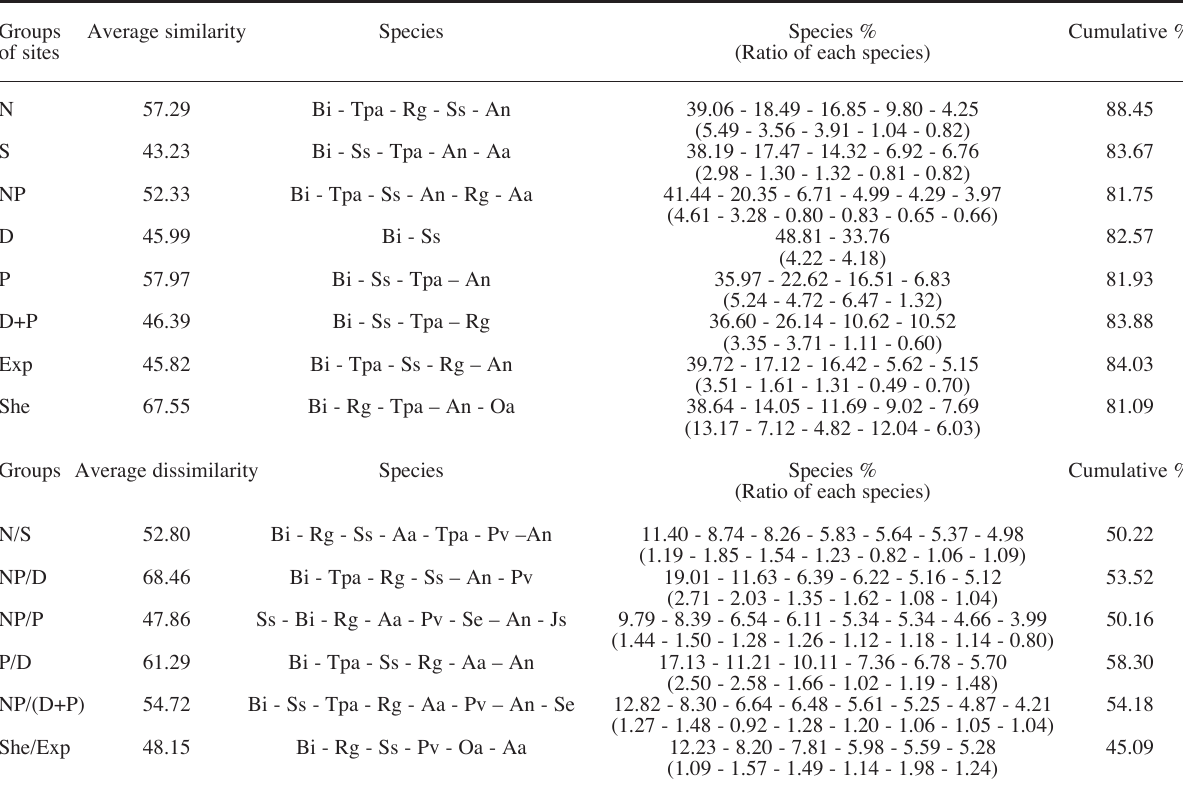
T ABLE 8. – SIMPER results. Data transformed by the formula y =(n /100 g ADW) 1/4 . Aa: Alvania angioyi . An: Anachis avaroides Bi: Bittium i i sp. Js: Jujubinus striatus . Oa: Ocinebrina aciculata . Pv: Parvicardium vroomi . Rg: Rissoa guernei . Ss: Setia subvaricosa . Se: Setia sp. Tpa: Tricolia pullus azorica . Other abbreviations as in Table